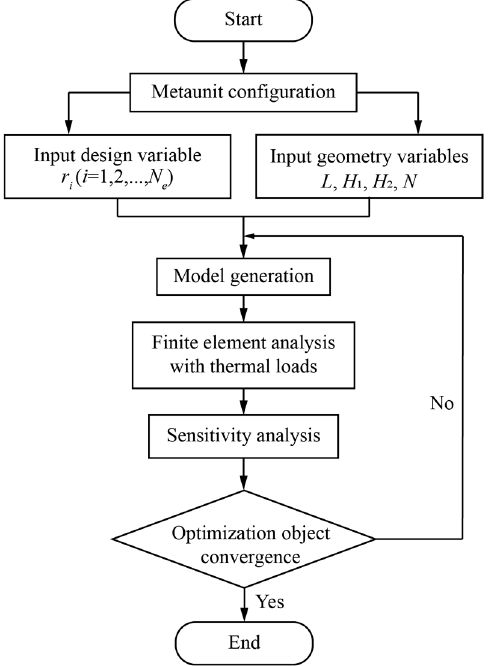
Figure 6. Flowchart of optimization